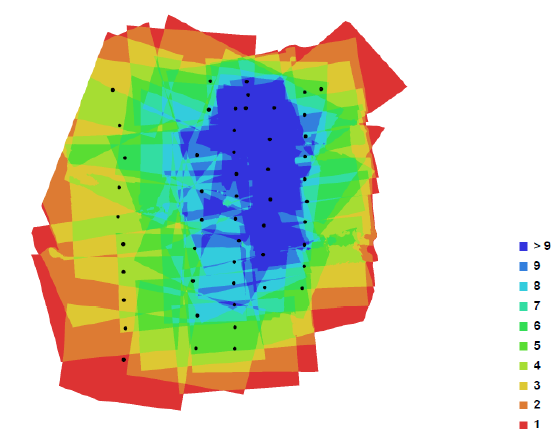
Figure 2 – Camera locations and image